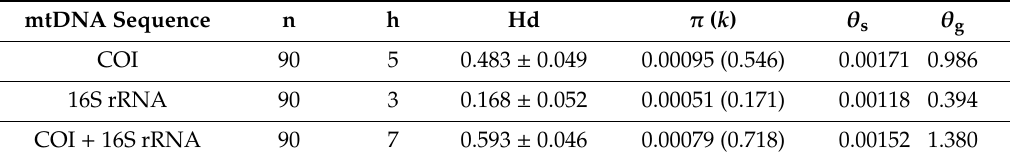
Table 6. Summary statistics of mtDNA genetic